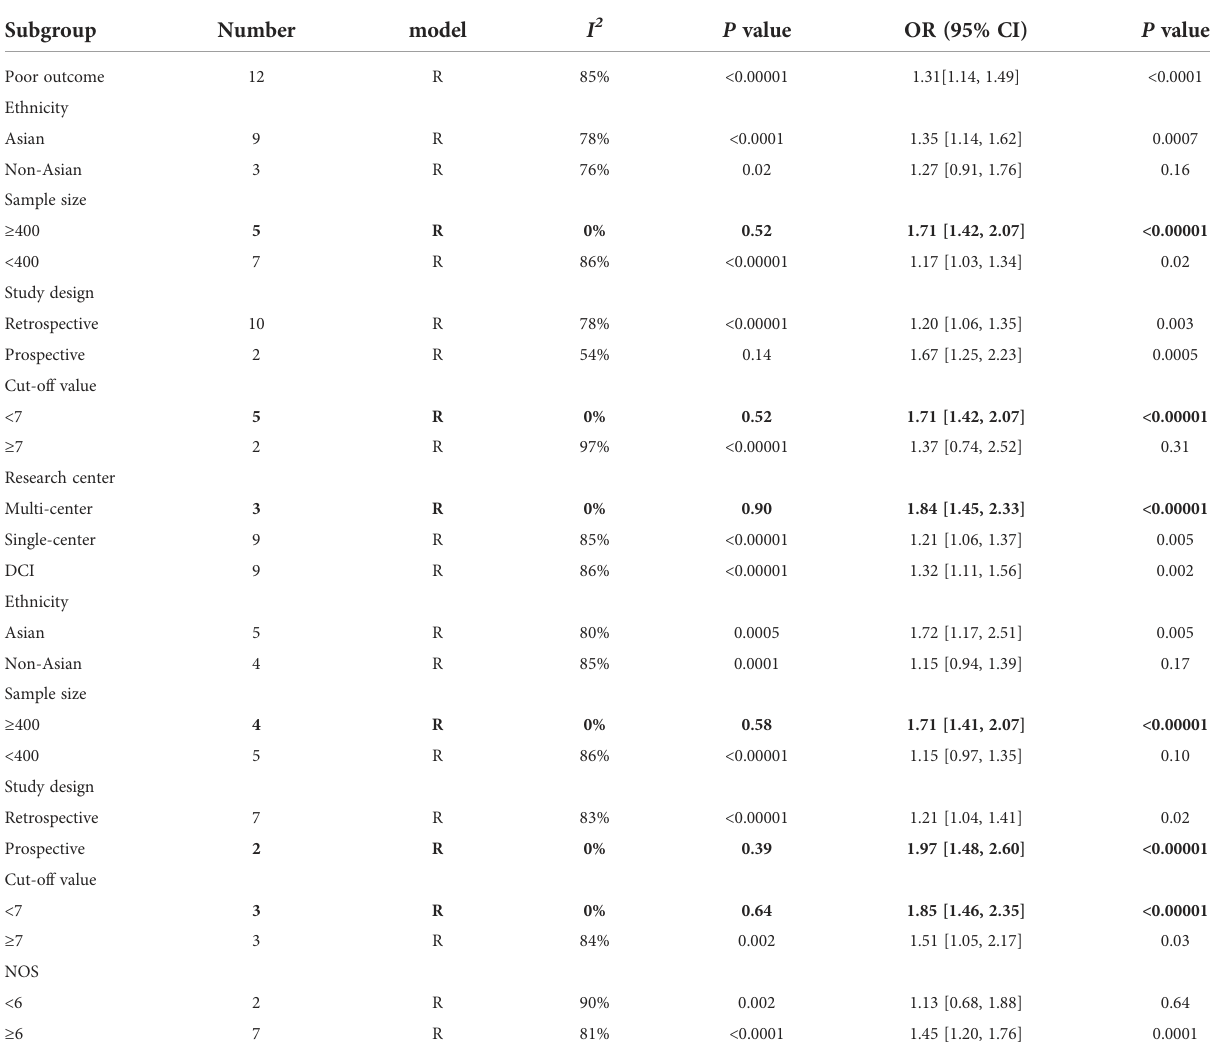
TABLE 4 Subgroup analysis of NLR with poor outcome and DCI